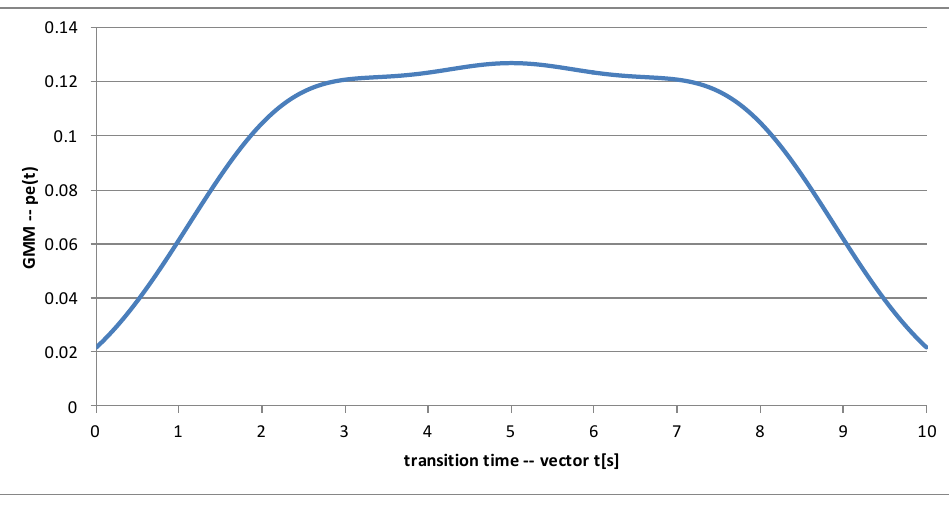
Figure 11. Just initialized GMM for the EM algorithm (iteration k = 0) of the EM